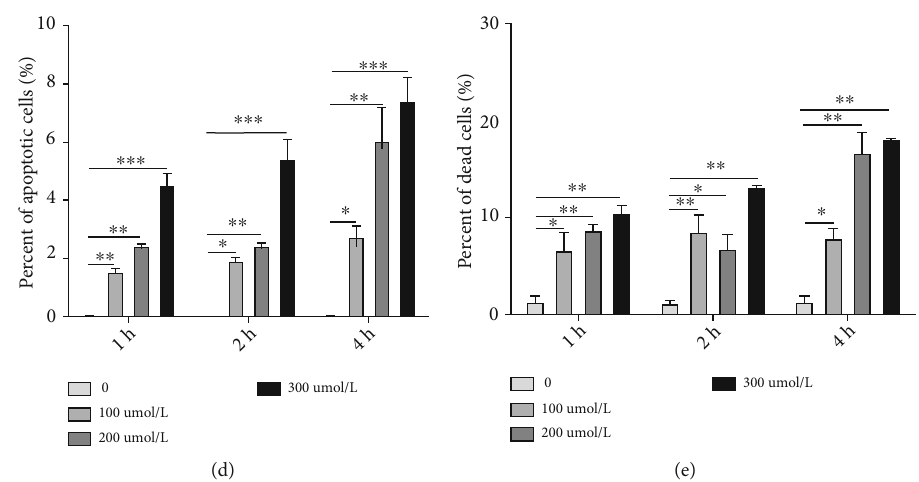
Figure 1: RB induced cell cycle arrest and cell death. (a) After the treatment for 24 h with di ff erent doses of RB, LLCs mainly exhibited G2/ M growth arrest. The gating strategy of cell cycle: First, the adherent cells were removed, and the cell cycle was analysed by the cell cycle model version of FlowJo v10. Software programs provided the estimate of cell percentage with fractional DNA content and cell cycle in sub-G1, G1, S, or G2/M phase. Three independent experiments were performed. (b) The percentage of cells with sub-G1 DNA content in LLCs. (c – e) RB induced cell apoptosis and necrosis in a dose- and time-dependent manner. Representative fl ow cytometry data are presented (c), and three independent experiments were performed (d, e). The gating strategy of cell necrosis: First, the cells were collected, and the voltage was adjusted with the blank control. Then, a new scatterplot was created, the target cells were gated (cross gate), and the scatterplot was fi nally compensated by FITC and DAPI single-stained controls. The assay was carried out in triplicate and repeated three times. The results are expressed as the meanvalues ± SD . One-way ANOVA was performed, and signi fi cance level was de fi ned as ∗ P < 0 : 05 , ∗∗ P < 0 : 01 , and ∗∗∗ P < 0 : 001